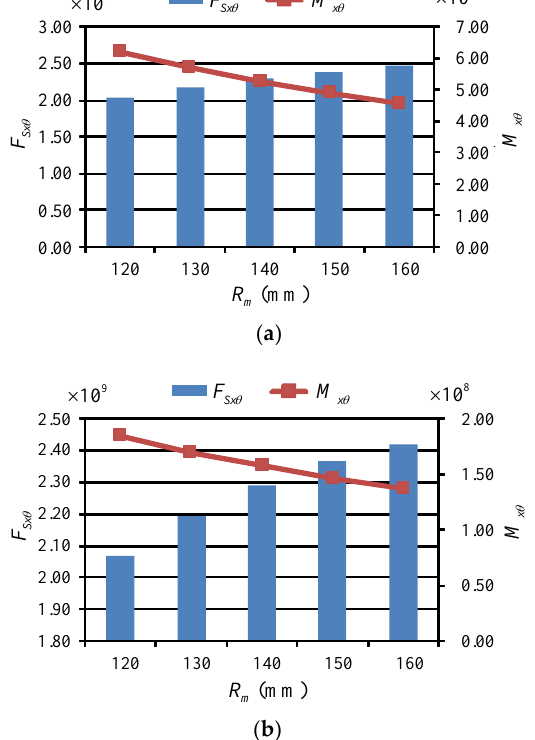
Figure 8. Effect of wall thickness δ on modes amplitudes with ( a ) B(2,1); ( b ) B(4,2).